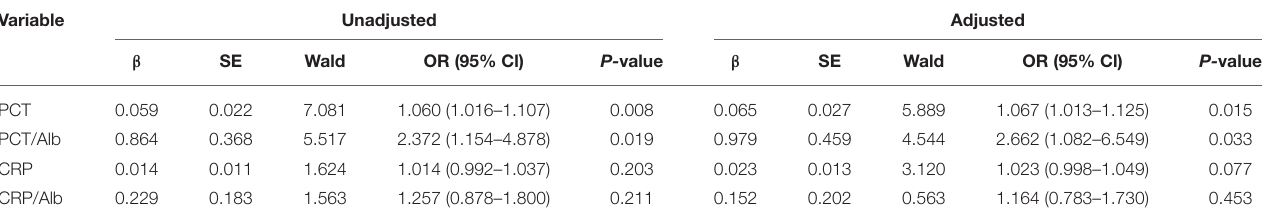
TABLE 3 | Multivariate logistic regression analysis of predictive values of PCT, PCT/Alb, CRP, and CRP/Alb in patients with sepsis-induced AKI. Variable Unadjusted